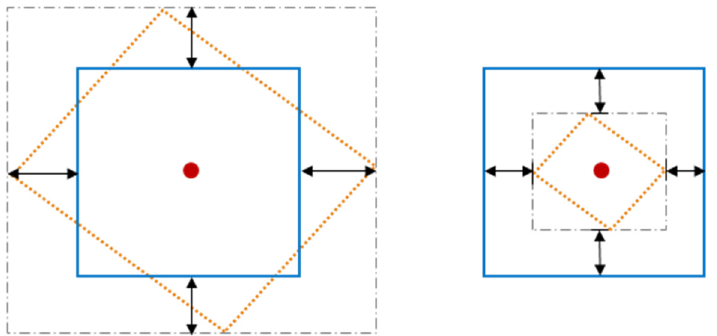
Figure 9. Augmentation of positive training samples. Two conditions of the bounding rectangle in different sizes are shown. The orange boxes indicate the source sub-images after transformation, the blue boxes indicate the corresponding target sub-images and the grey boxes indicate the bounding rectangles of the orange boxes. The red points are the centers of the sub-images, and the black arrows show the scope where the windows of augmented target sub-images can randomly shift.